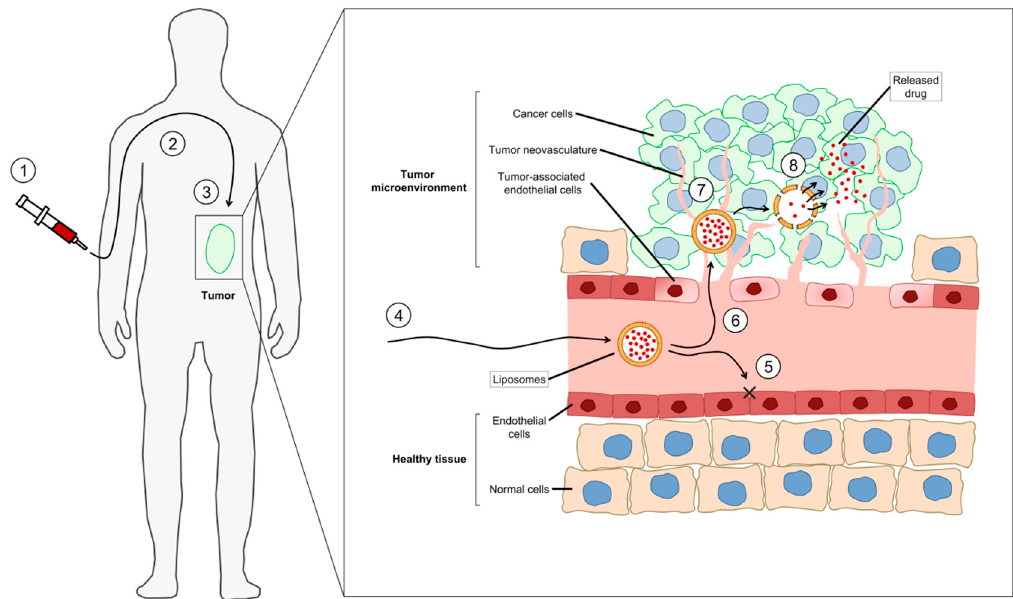
Figure 3. Passive targeting of liposomal formulations by the enhanced permeability and retention (EPR) effect. ( 1 ) Liposomes are administered intravenously to cancer patients. ( 2 ) They enter the blood flow and remain in circulation for extended periods of time, due to their large particle size and improved pharmacokinetics, while the drug cargo is protected from degradation. ( 3 , 4 ) Liposomes arrive at the tumour through the blood vessels. ( 5 ) They are not able to extravasate to healthy tissue because of the compact endothelial cell layer ( × ) that forms the capillaries. ( 6 ) However, they escape from blood circulation through the enhanced permeability of the tumour neovasculature, which is poorly formed, inflamed and “leaky”. ( 7 ) Liposomes are retained in the tumour microenvironment, since the associated lymphatic vessels are impaired. ( 8 ) The encapsulated drug is released from the accumulated liposomes into the tumour microenvironment and finally internalised by cancer cells. The arrows show the distribution of the liposomal drug from the intravenous administration to the accumulation and release into the tumour microenvironment.